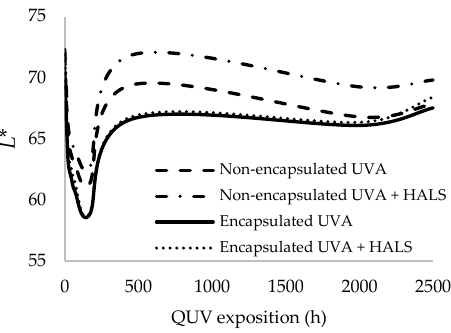
Figure 14. L * component evolution for the different formulations studied with QUV exposure.